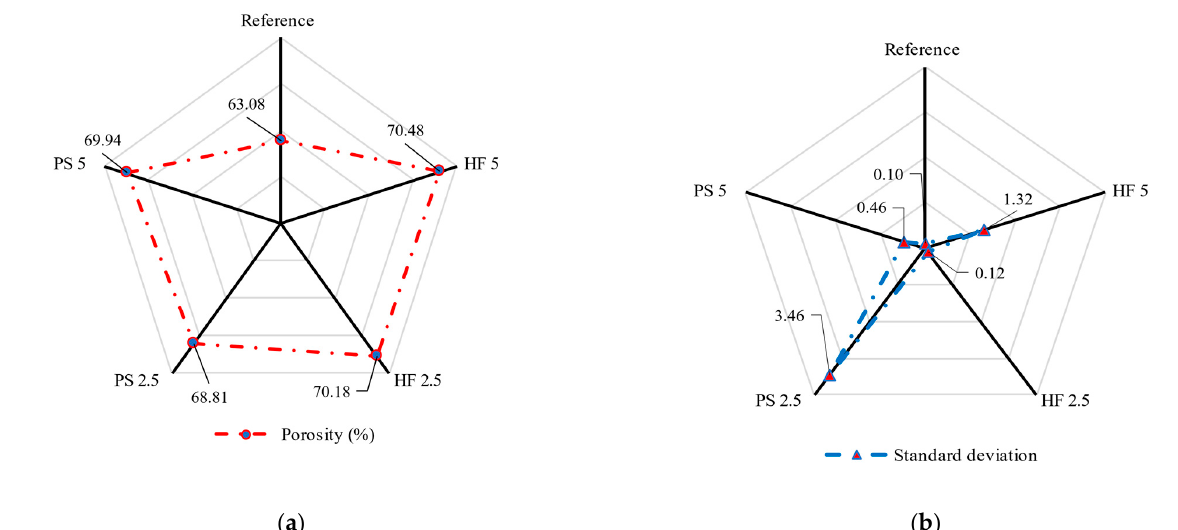
Figure 7. ( a ) Porosity of fiber mortar and ( b ) standard deviation.